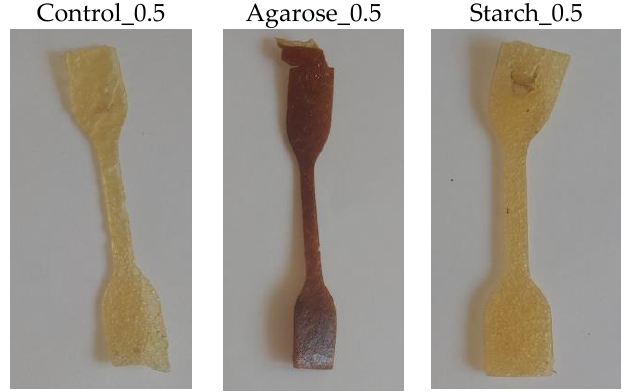
Figure 9. Samples after thermo-oxidative aging. Based on the appearance of the samples after the thermo-oxidative aging process, organolep- slightly decreased flexibility.